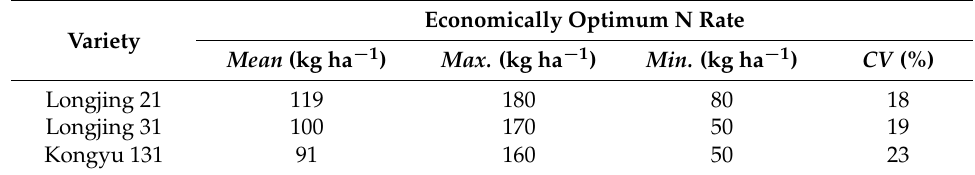
Table 3. Descriptive statistics of simulated, economically-optimum N rates that maximized marginal net return for the years of 1960–2014. Max. and Min. standard for maximum and minimum,